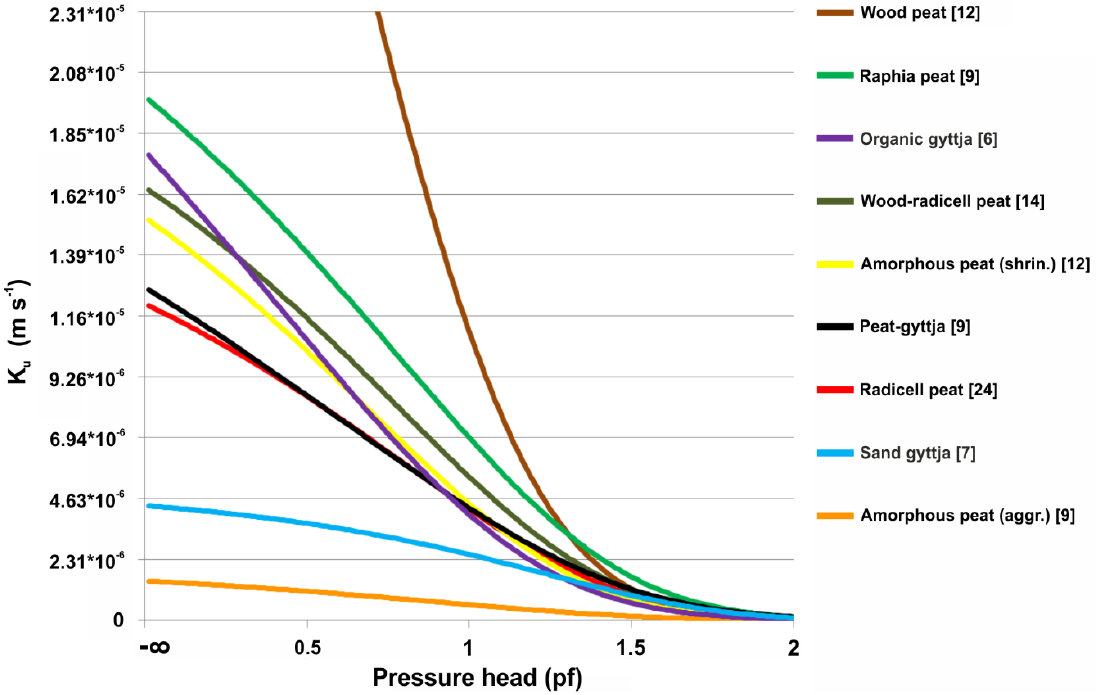
Figure 7. Unsaturated hydraulic conductivities calculated using Equation 2; number of samples [n] in square brackets.